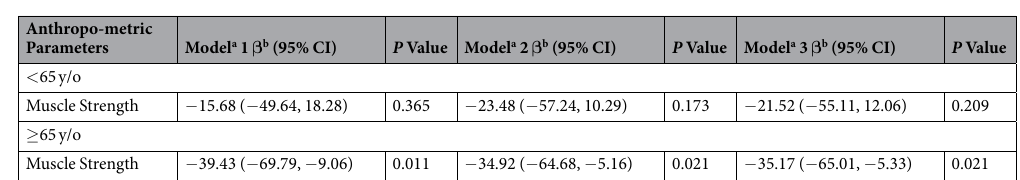
Table 4. Association between the serum phosphate and the muscle strength in elderly participants. Model 1 = Unadjusted. Model 2 = Model 1 + age, sex, race/ethnicity + BMI, serum fasting glucose, serum cholesterol, AST, serum HDL, serum calcium, serum creatinine. Model 3 = Model 2 + history of congestive heart failure, coronary heart disease, angina/angina pectoris, heart attack, stroke,